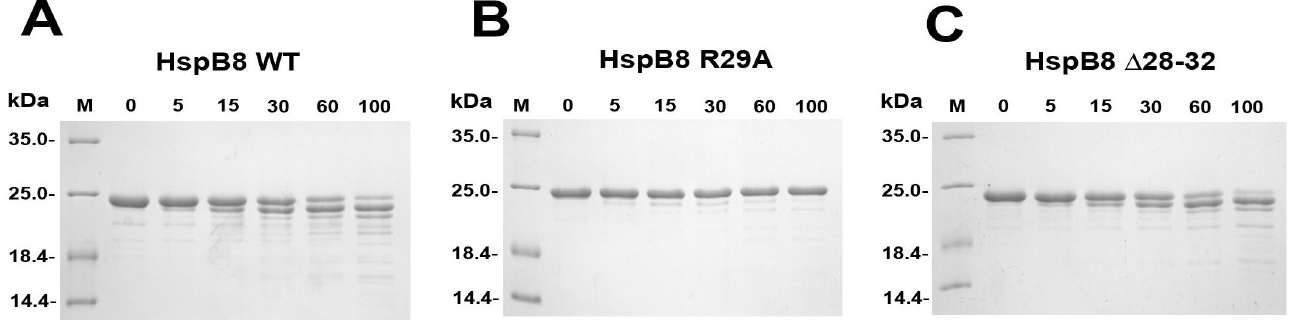
Fig 4. Limited chymotrypsinolysis of HspB8 WT (A), and its R29A (B) and Δ 28–32 (C) mutants. Incubation time (min) is indicated above each lane. Positions of protein markers with their Mw values (in kDa) are marked by lines.